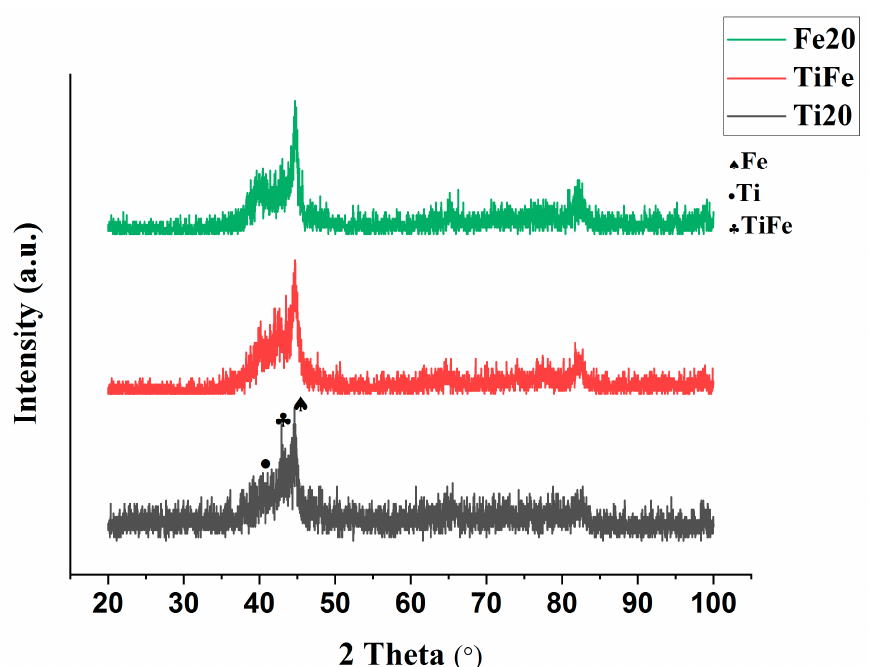
Figure 5. XRD patterns of Ti20, TiFe, and Fe20 alloys after 10 h of